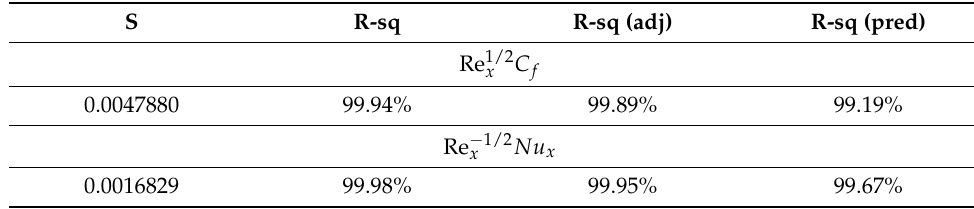
Table 8. Model summary for the